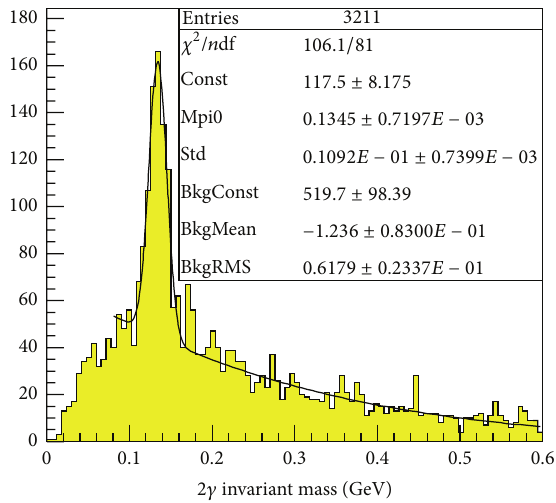
Figure 8: 2 𝛾 invariant mass distribution showing the signal of 𝜋 0 (from